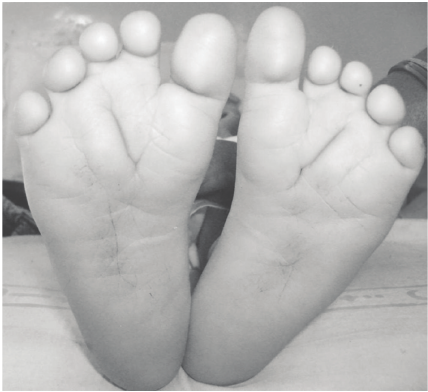
Figure 1: Characteristic deep plantar